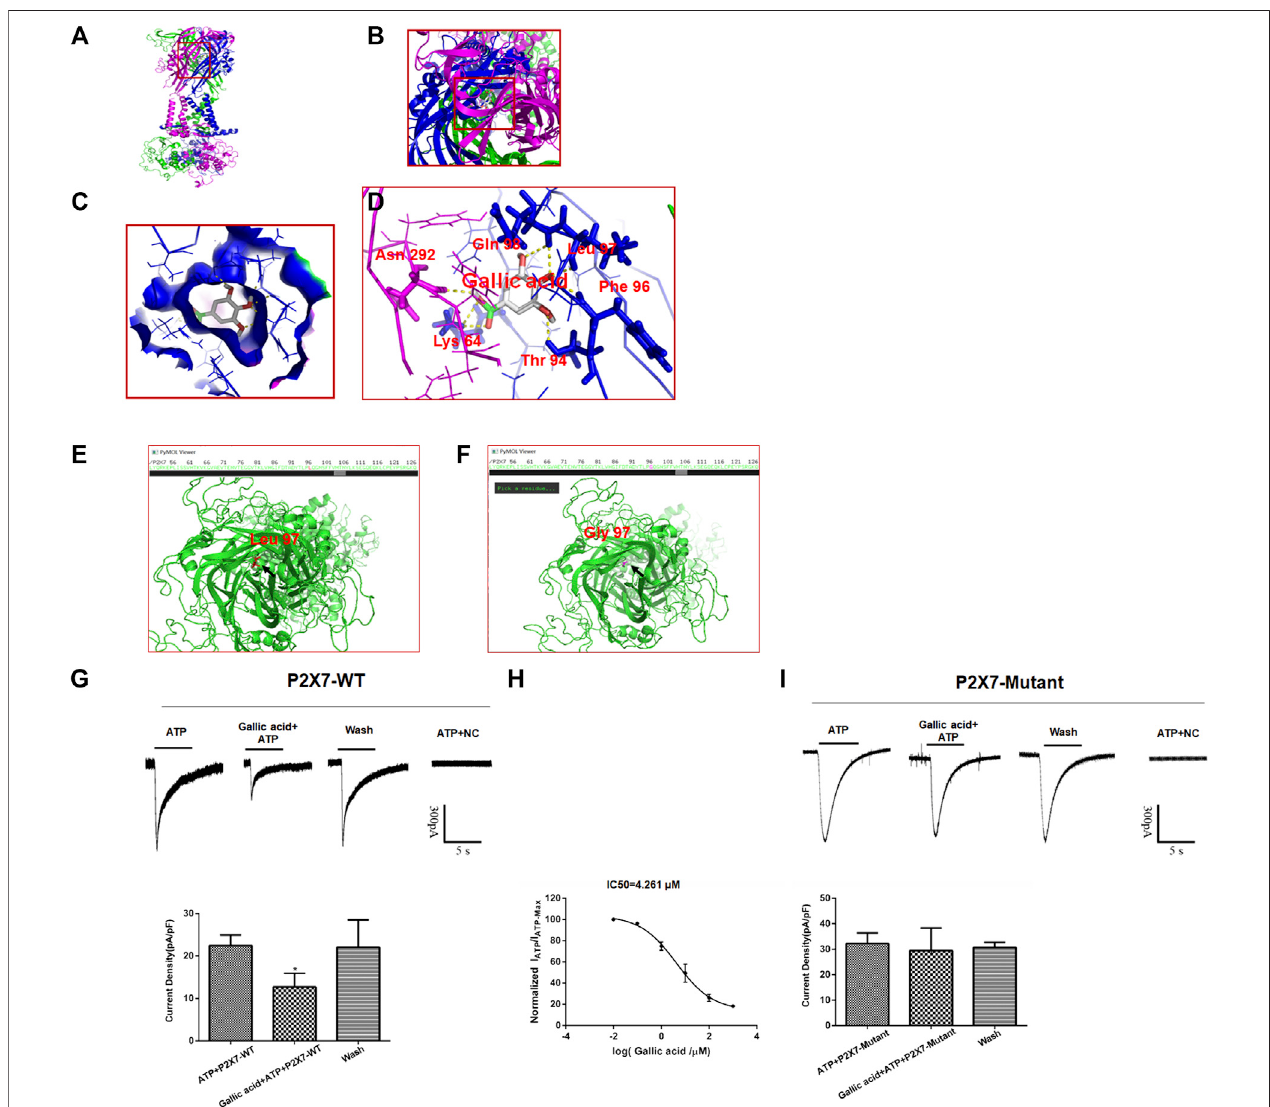
FIGURE 5 | The results of molecular docking and whole-cell patch-clamp. The molecular docking result showed the best binding position between gallic acid and P2X7. The positive view (A) and top view (B) show the best binding position between gallic acid and P2X7 (C). The binding pocket of gallic acid and P2X7 receptor (D). The best binding site of gallic acid and P2X7; the yellow dotted line represents the hydrogen bond of the combination of both. The P2X7 receptor mutation diagram shows the mutation site (E). The arrow seen in the top view of the wild-type P2X7 receptor indicates a red residue of Leu97 (F). The arrow in the top view of the mutant P2X7 receptor indicates that the purple residue is Gly97. Effect of gallic acid on ATP activated current in HEK293 cells transfected with hP2X7 recombinant plasmid (G). Effect of gallic acid on ATP-activated current in HEK293 cells transfected with pcDNA3.0-EGFP-hP2X7 (P2X7-WT) was showed (F (2, 6) (cid:2) 5.634, p (cid:2) 0.0165) (H). Inhibition of ATP activation current in HEK293 cells transfected with wild-type P2X7 receptor by different gallic acid concentrations (IC50 (cid:2) 4.261 μ M). (I). Effect of gallic acid on ATP-activated current in HEK293 cells transfected with P2X7-pEGFP-C1-MUT (P2X7-Mutant) was showed (F (2, 6) (cid:2) 0.2648, p (cid:2) 0.7759). The results were analyzed by one-way ANOVA. Data are presented as mean ± SEM, * p < 0.05 versus the ATP alone